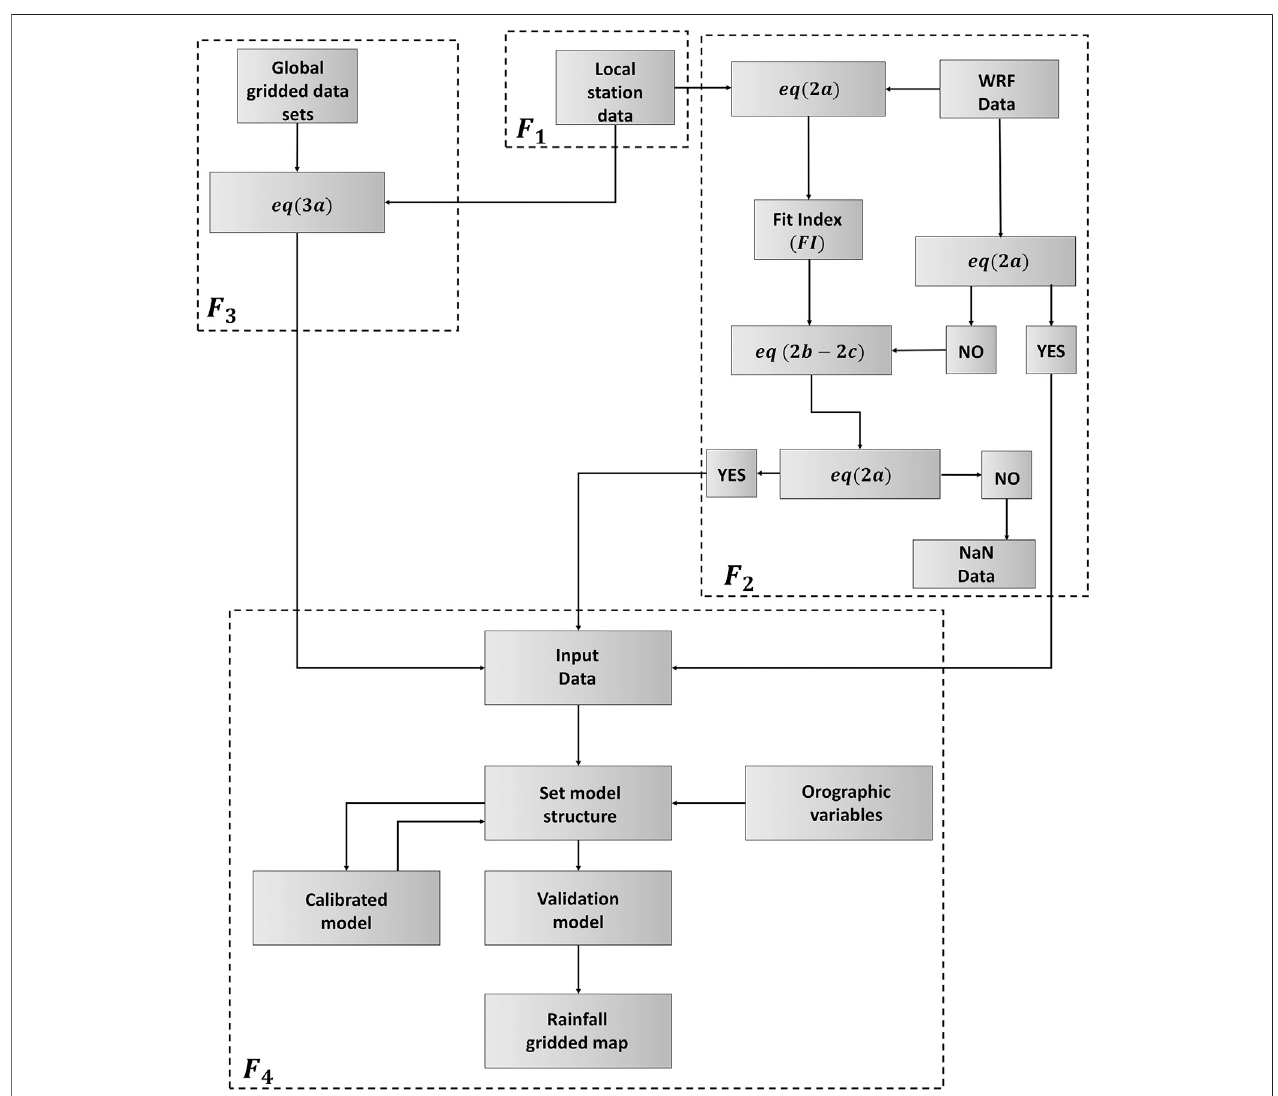
FIGURE 5 | Schematic overview of the dynamic topo-climatic model development.